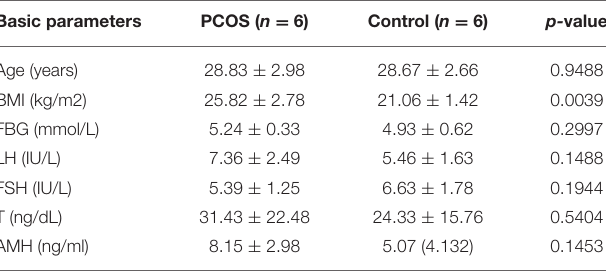
TABLE 1 | Clinical and endocrine parameter of PCOS patients and controls enrolled in high throughput sequencing. Basic parameters